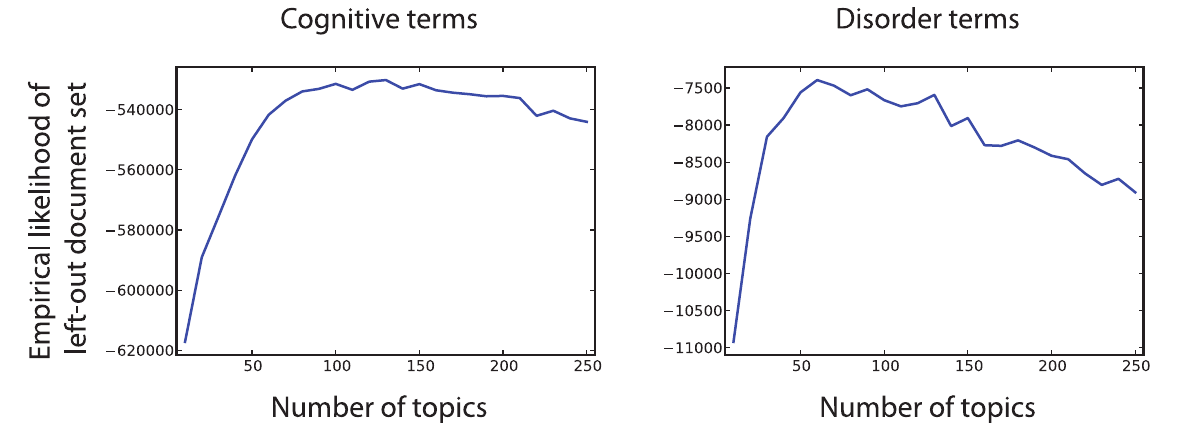
Figure 2. Plots of the average empirical likelihood of the left-out document sets across cross validation folds, for cognitive terms (left) and disorder terms (right).